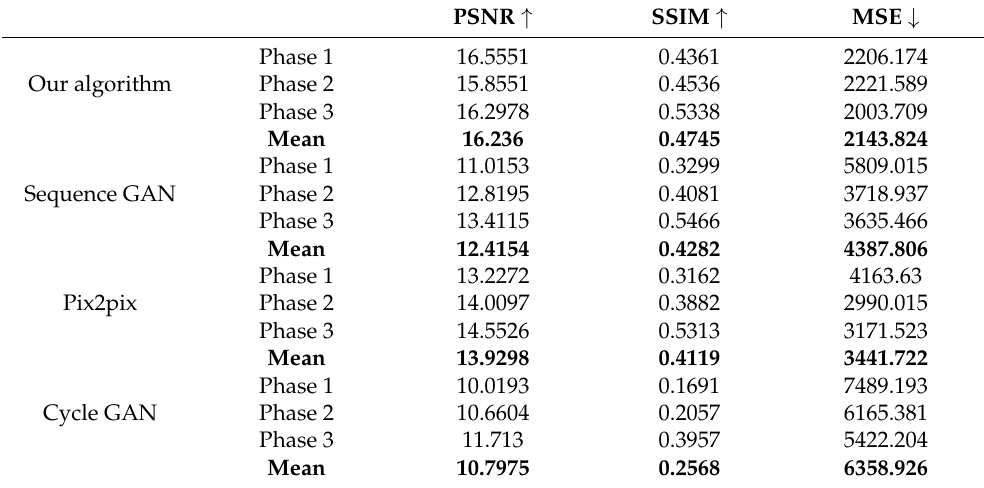
Table 1. Comparison of the similarity metrics for translated FFA: overall PSNR, SSIM [24], and MSE. PSNR